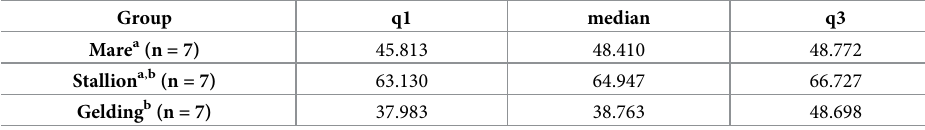
Table 1. The values of transepidermal water loss (TEWL) in the lip region. Group